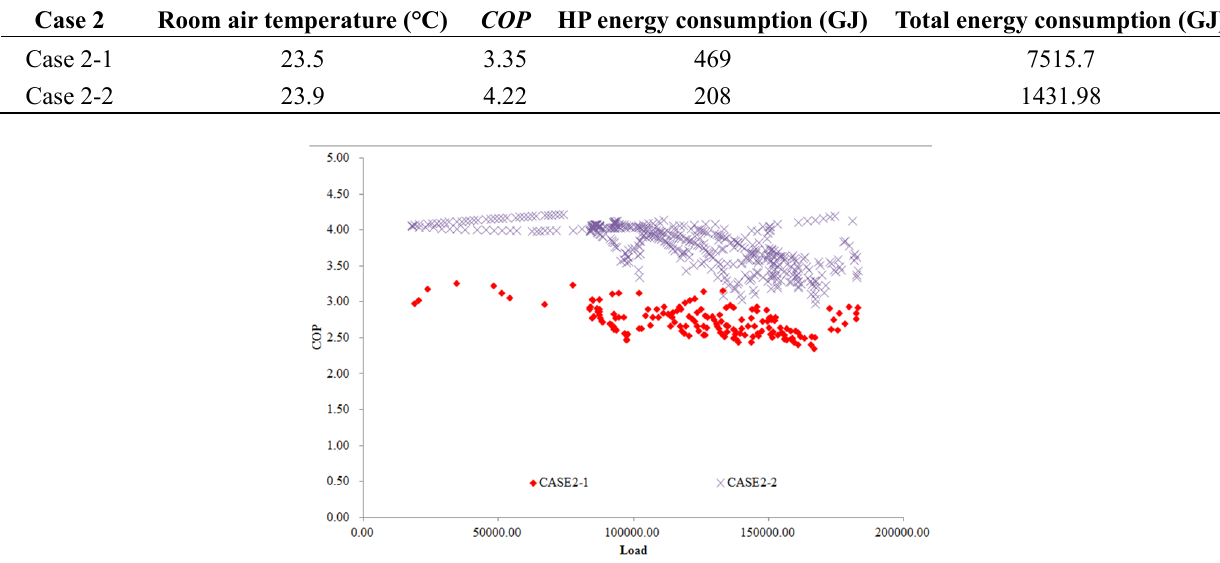
Figure 18. COP and load relationship graph of combination with the Multi-GHP systems and the ABS chiller-heater system: Case 2-1: existing operation condition of the Multi-GHP system and ABS chiller-heater system; Case 2-2: sequencing operation condition of the Multi-GHP system and ABS chiller-heater system.